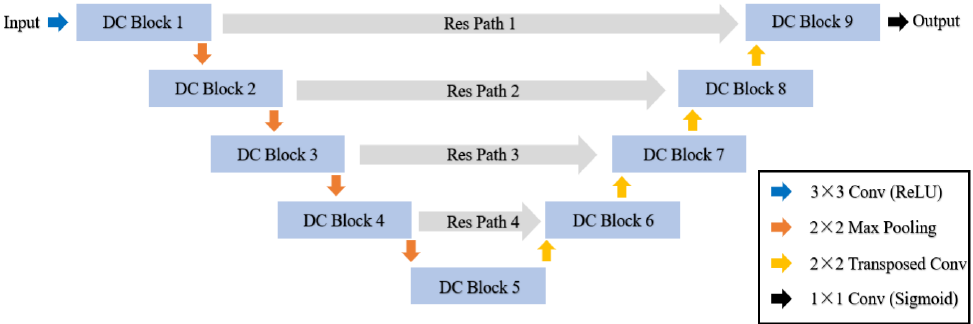
Figure 2. DCU-Net architecture (adapted from